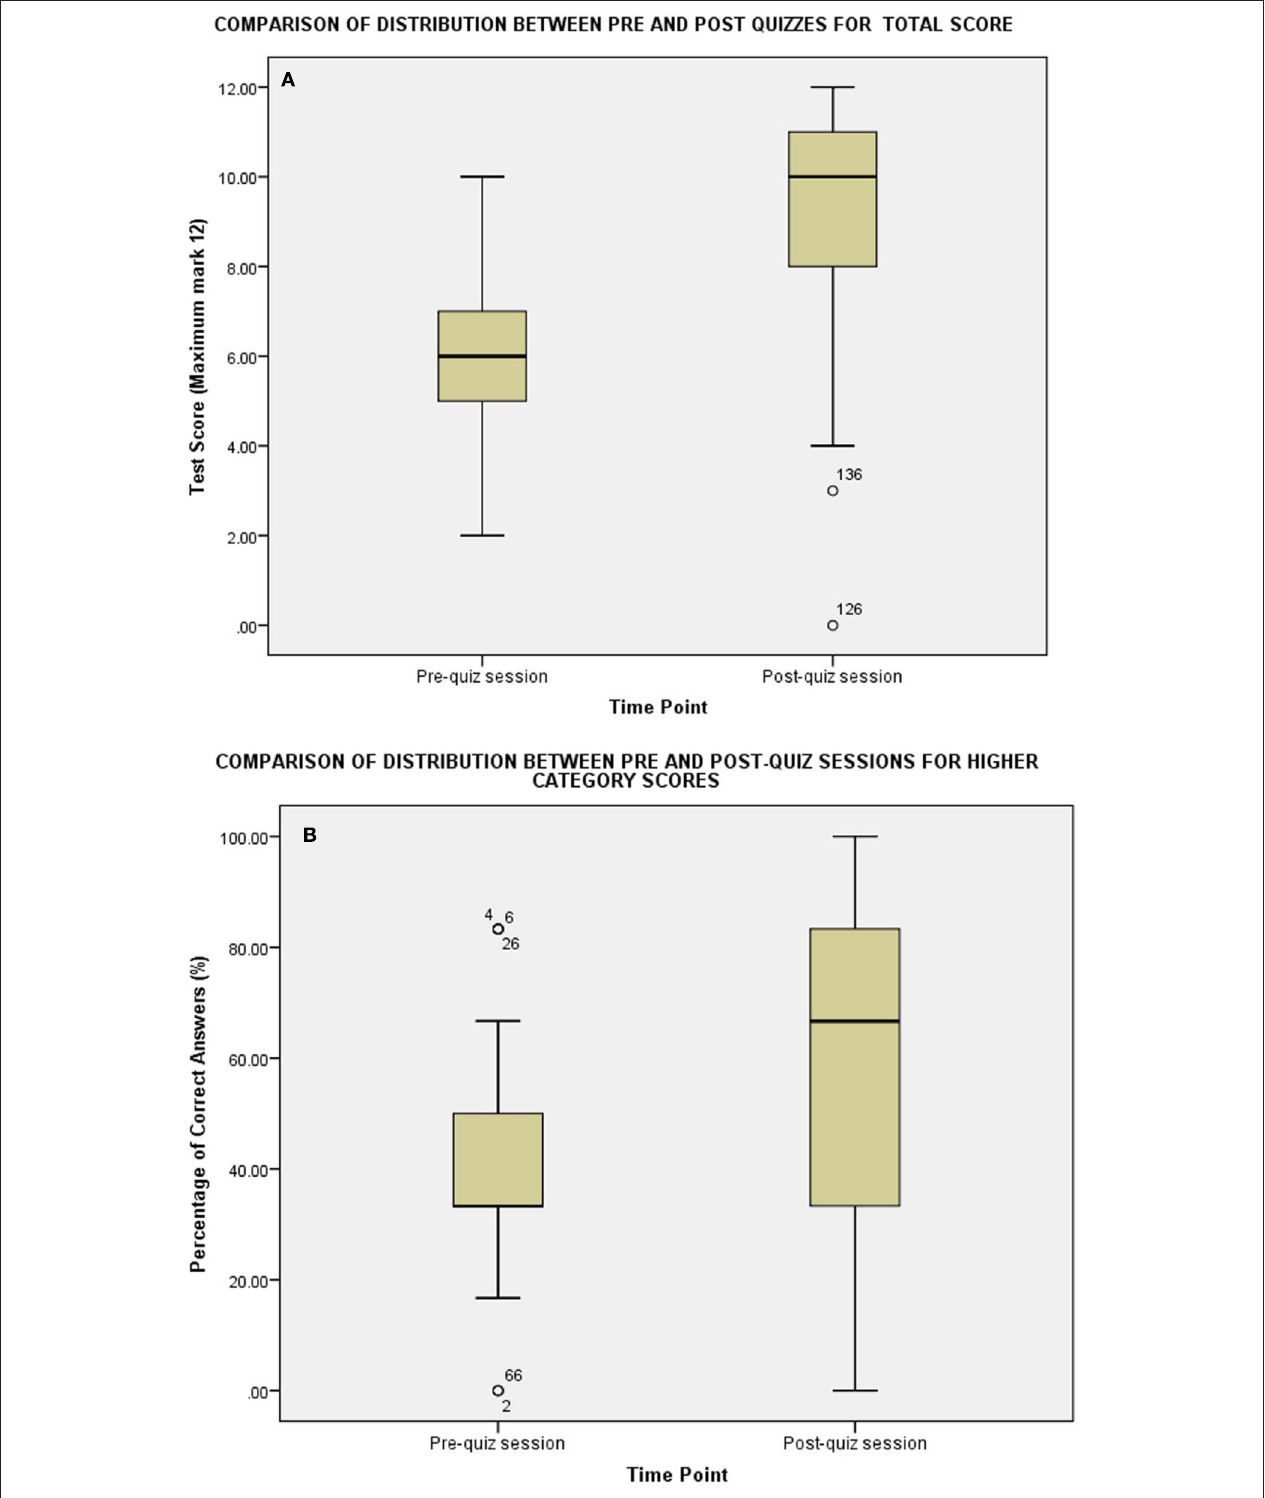
FIGURE 1 | Box and whisker plot to demonstrate the distribution of data over pre- and post-quiz sessions for (A) total score and (B) the higher-category questions. (pre-quiz n = 68 and post-quiz n = 94).